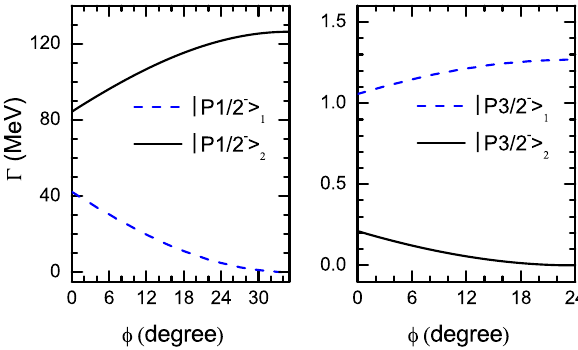
Fig. 2 Partial decay widths for the J P = 1 / 2 − and J P = 3 / 2 − (cid:2) b states as a function of the mixing